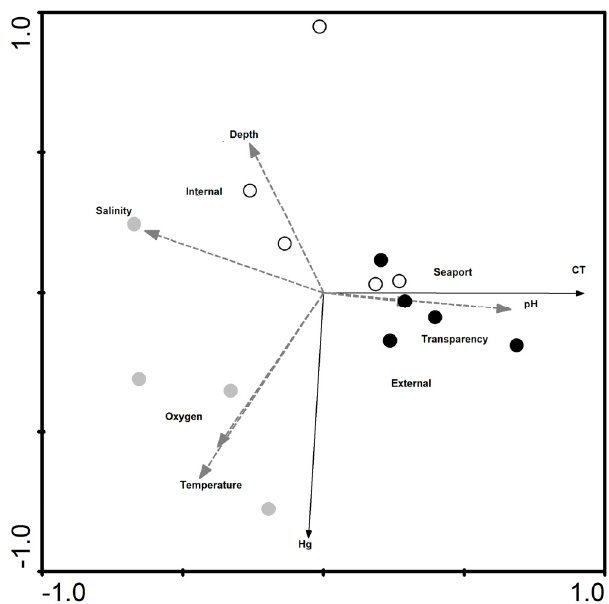
Figure 4. RDA performed using abiotic data (Depth, salinity, oxygen, transparency, pH, temperature), Hg concentrations and length (CT) in swimming crabs, taking into account mainly period (before, during and after the dredging) and secondarily the sample region, dividing in Seaport, external and internal areas of the Guanabara bay. The circles represent the collection points. White circles represent the collection points prior to dredging, gray during and black, after.